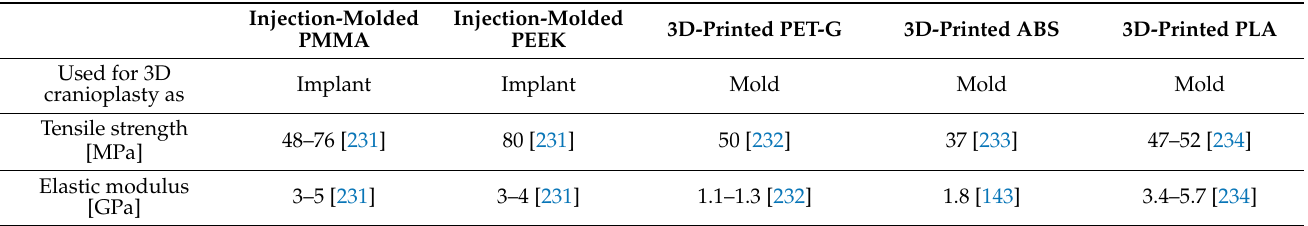
Table 3. Characteristics of 3D-printed